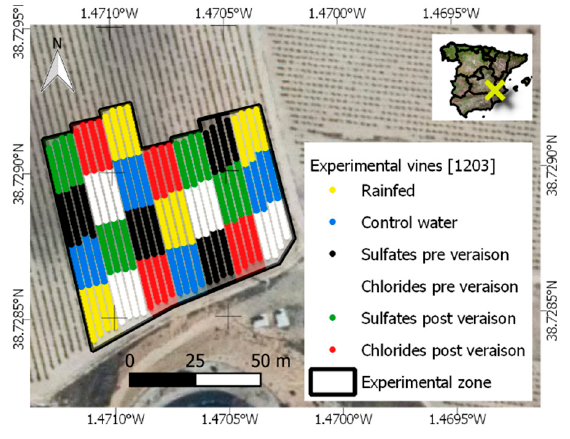
Figure 3. Situation map (EPSG:3857).